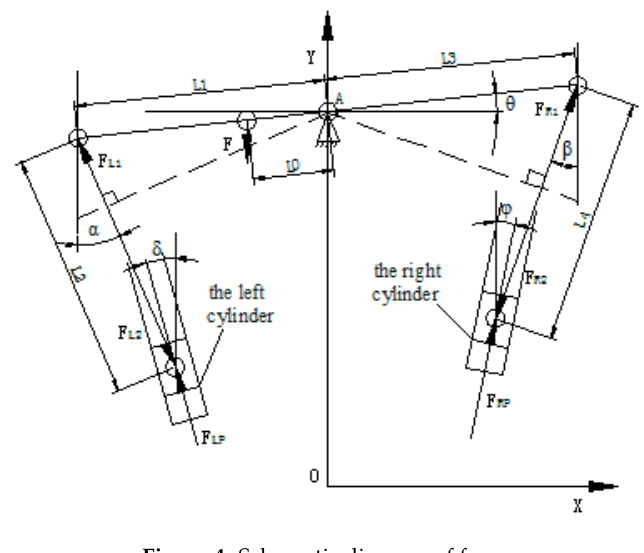
Figure 4. Schematic diagram of force.